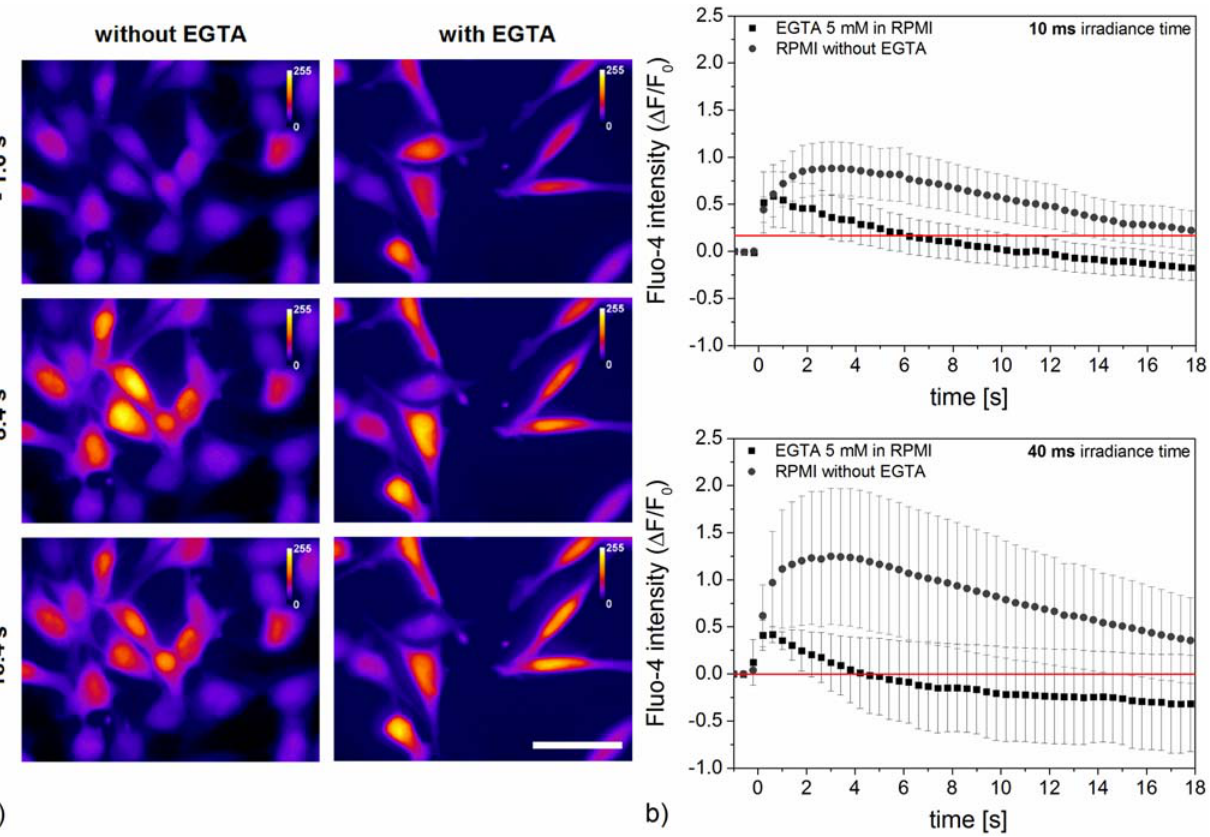
Fig 6. Normalized fluorescence of calcium indicator Fluo-4 with and without addition of calcium chelator EGTA. a) Fluorescence images at different points in time referring to supplemental video S2 Video. Scale bar 50 μ m. The color map calibration is different for both columns. b) Time-dependence of Fluo-4 intensity relative to its initial value after laser manipulation at zero seconds. 5 mM EGTA was used as calcium chelator in RPMI 1640. Radiant exposure was fixed to 27 mJ/cm 2 . The peak increase with 5 mM EGTA compared to normal conditions is lowered. Signal decrease below base level is most likely explained by photobleaching. The mean and standard error of three experiments with five irradiated and analyzed cells are shown.